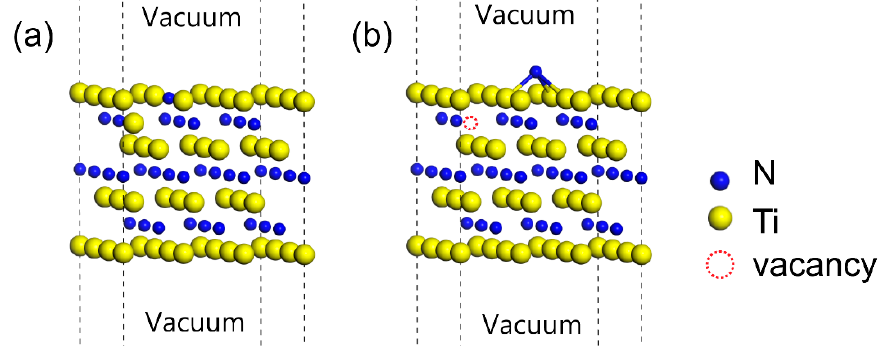
Figure 5. Schematic of the Ti-N swapped ( a ) before and ( b ) after geometric optimization on the Ti 4 N 3 nanosheet.